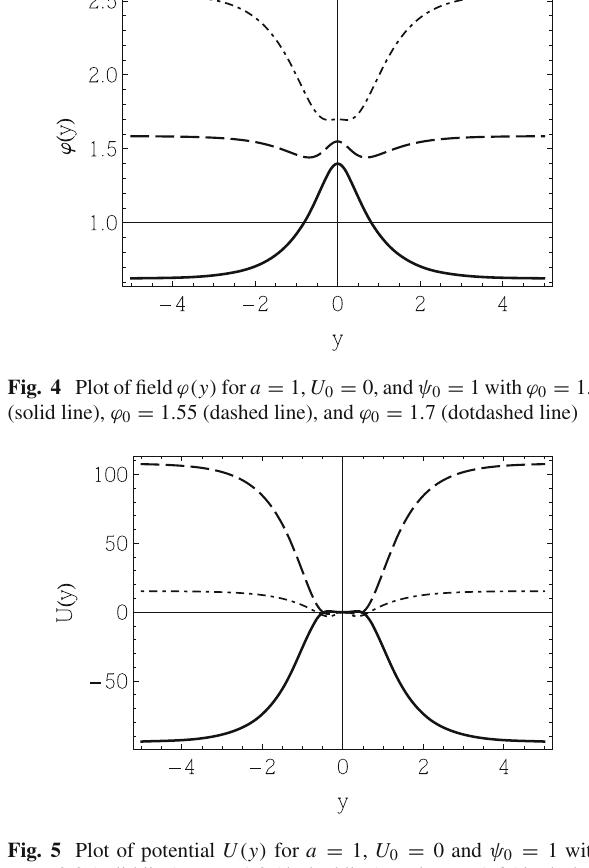
= 1 . 3 (dashed line), and ϕ 0